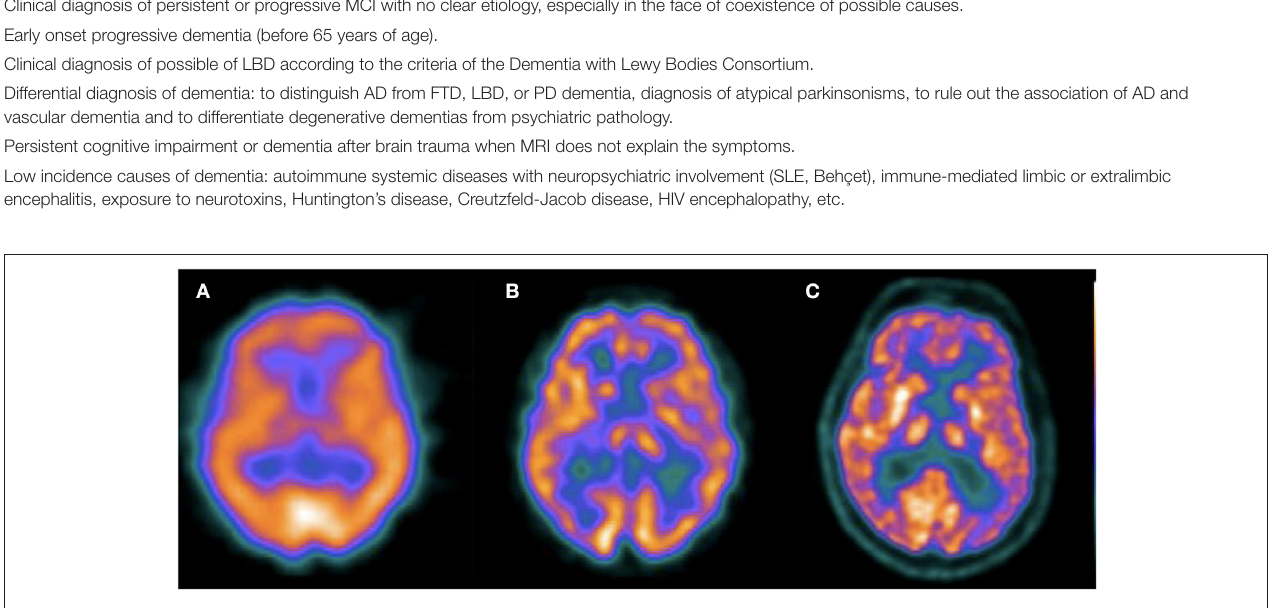
Frontiers in Neurology |